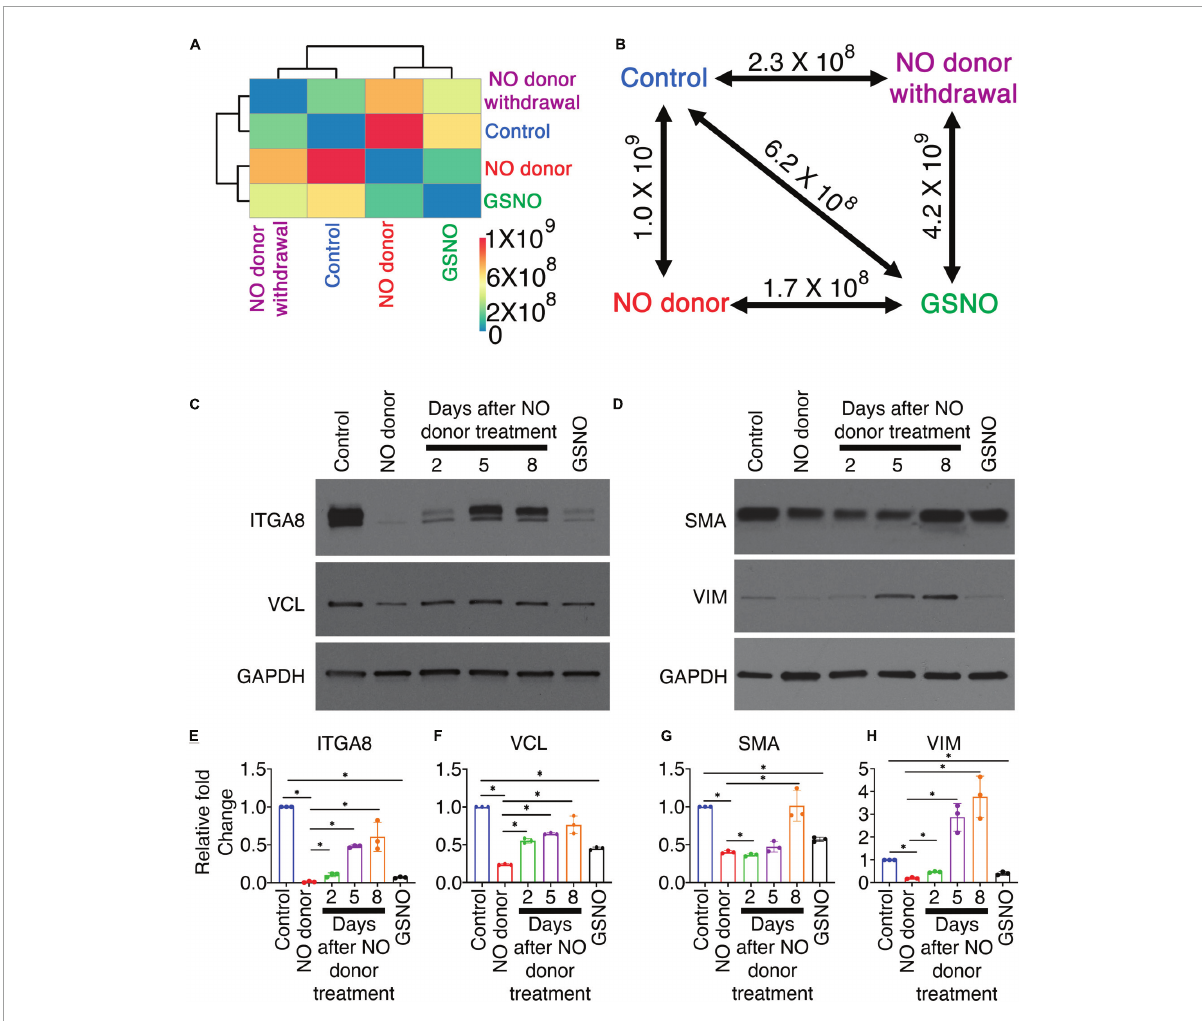
FIGURE4 Nitric oxide (NO)-dependent transcriptional responses in porcine aortic valve interstitial cells (pAVICs) are short-lived. (A) Heatmap showing the Spearman distance between different pairs of culture conditions calculated based on the normalized average expression of 1,247 selected genes of pAVICs, cultured for 5 days in the absence (control) and presence of NO donor or S-nitrosoglutathione (GSNO) or a culture condition where NO donor was present for first 3 days and absent for remaining 2 days (NC). (B) Diagram represents the Spearman distance between groups and is denoted as Spearman distance (SD), comparing any two-culture condition marked by a double-headed arrow. (C,D) Immunoblots show expressions of ITGA8 (Integrin α 8), VCL (vinculin), SMA (smooth muscle actin), and VIM (vimentin) in pAVICs, cultured for 5 days in the absence and presence of NO donor, GSNO, and without NO donor after 3 days of NO donor treatment. After 3 days of NO donor treatment, pAVICs were cultured for additional 2, 5, and 8 days without NO donor. Glyceraldehyde 3-phosphate dehydrogenase (GAPDH) was utilized as a loading control. (E–H) Graphs show quantification of ITGA8, VCL, SMA, and VIM, respectively, from immunoblots shown in panel (C,D) . *Indicates P ≤